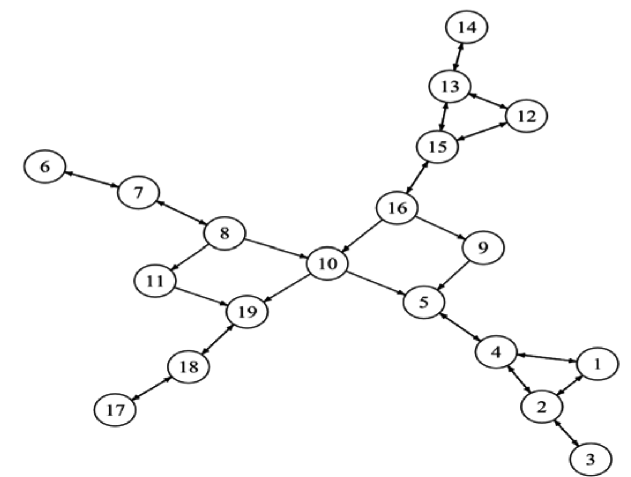
Figure 3. Transition graph Source: authors’